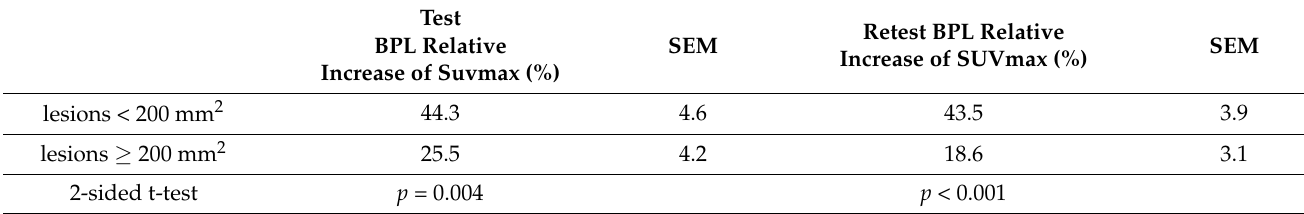
Table 2. BPL SUVmax increase (relative to standard reconstruction) for smaller and larger